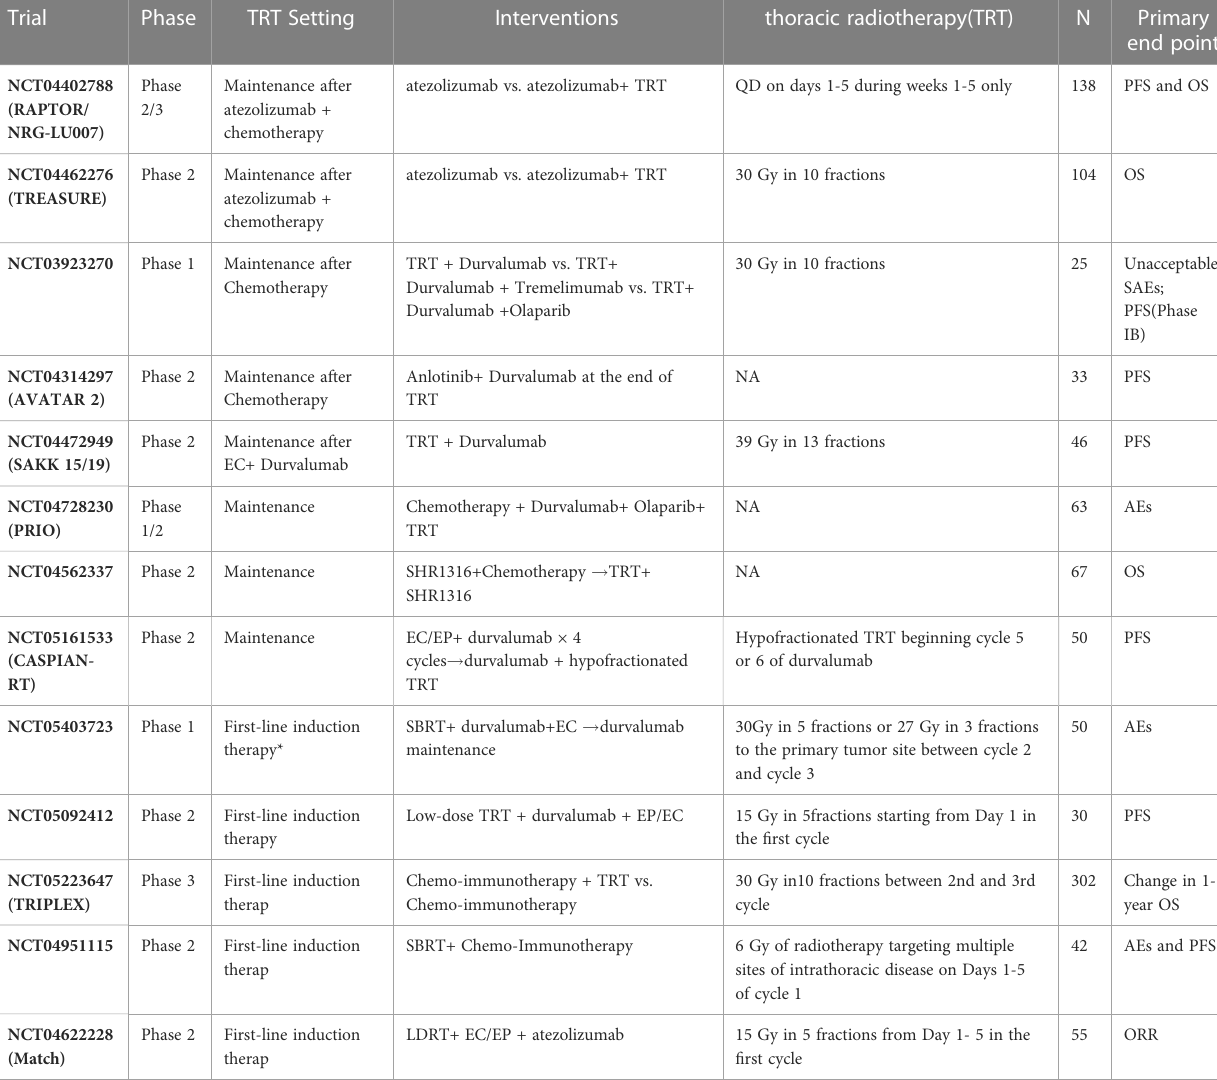
TABLE 2 Select ongoing trials with immunotherapy plus thoracic radiation therapy in